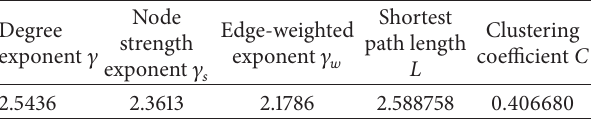
Table 1: Main topological properties of the